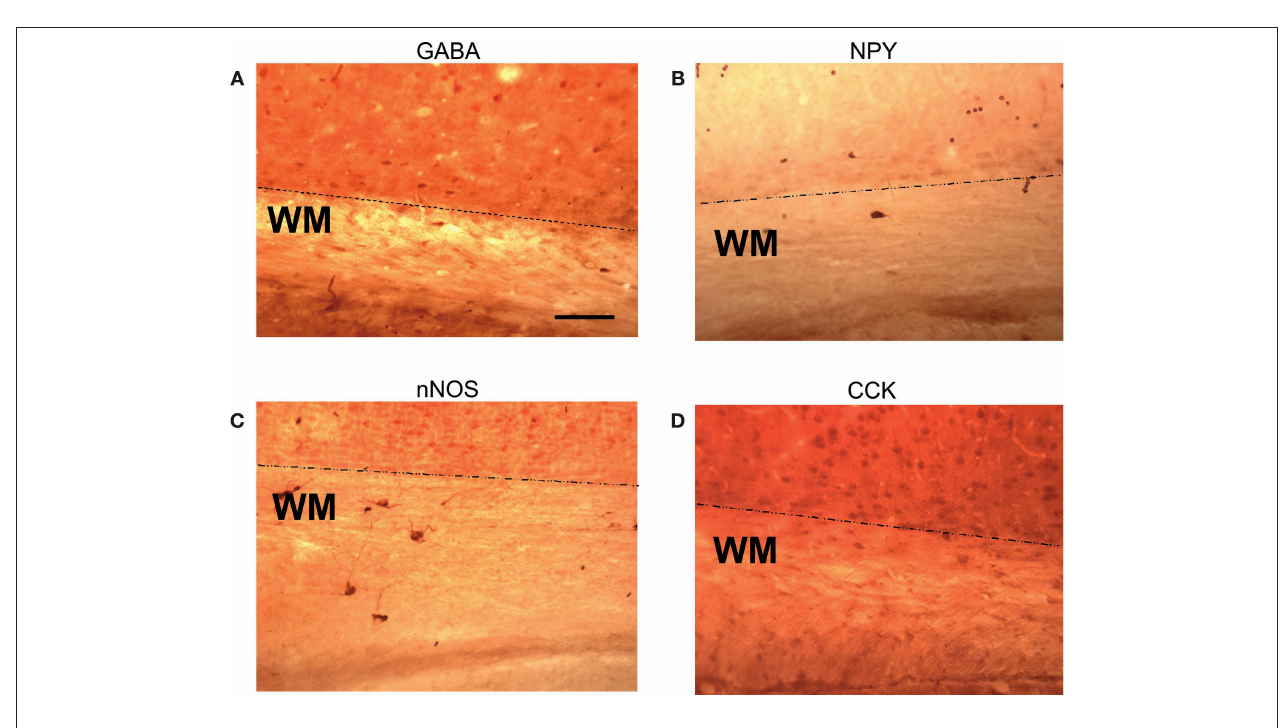
FIGURE 6 | WM and SP neuron immuno-positivity for four neuromodulatory compounds. Four sections of rat visual cortex (postnatal day 12–14) that were immuno-stained for various neuromodulators. (A) anti-GABA;